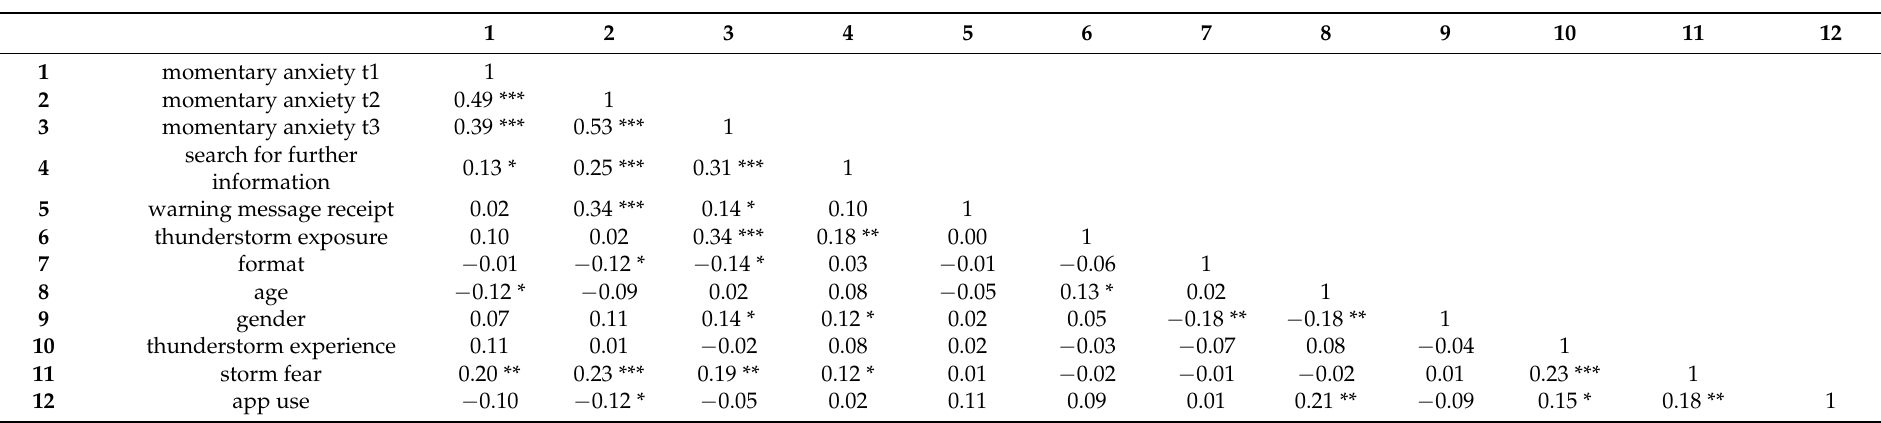
Table 1. Pairwise (Pearson) correlations of momentary anxiety (t1–t3), search for further information, warning message receipt, thunderstorm confrontation, and presentation fomat, including covariates (age, gender, thunderstorm experience, storm fear, app use), n =